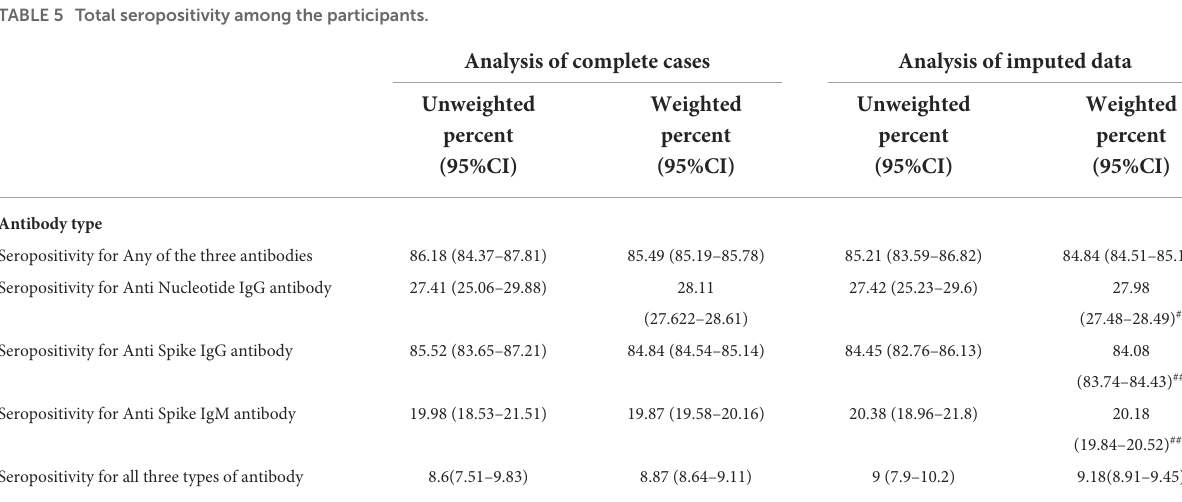
TABLE 5 Total seropositivity among the